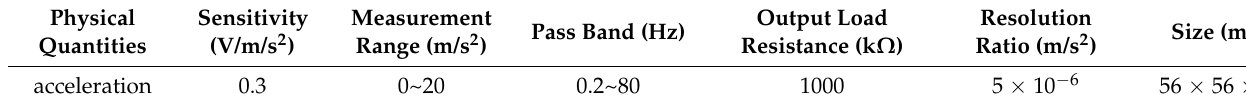
Table 1. Technical parameters of the vibration sensor (JX941).